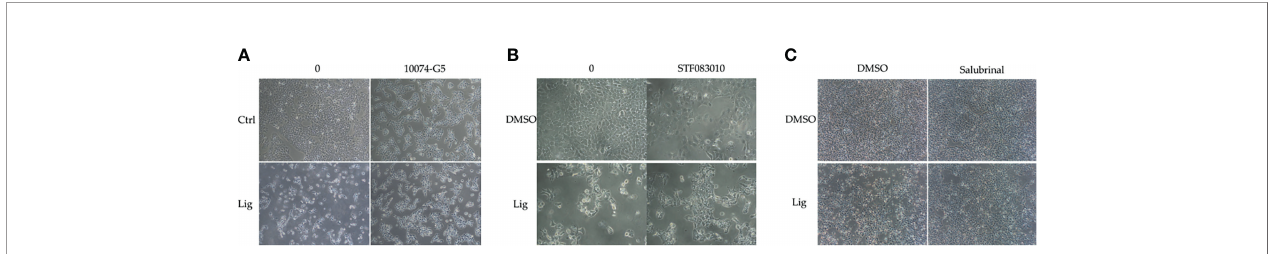
FIGURE 4 | Effects of inhibitors on ligustilide-treated cells. TW2.6 cells were pretreated with inhibitors individually ( A , 10074-G5: 5 m M; B , STF083010: 7.5 m M; C , Salubrinal: 40 m M) for 30 min and then with ligustilide (200 m M for group 10074-G5 and STF083010; 100 m M for group salubrinal). Images were taken at 24 h of hypoxia. Images for 10074-G5 are presented at 100 times magni fi cation while those for STF083010 and salubrinal were at 200 and 60 times magni fi cation, respectively.